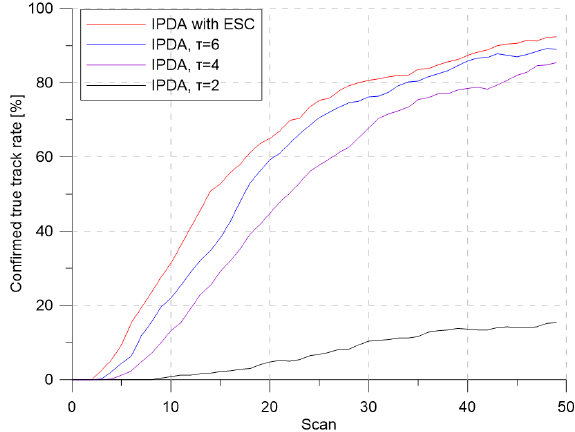
Figure 9. Confirmed true track rate for λ =